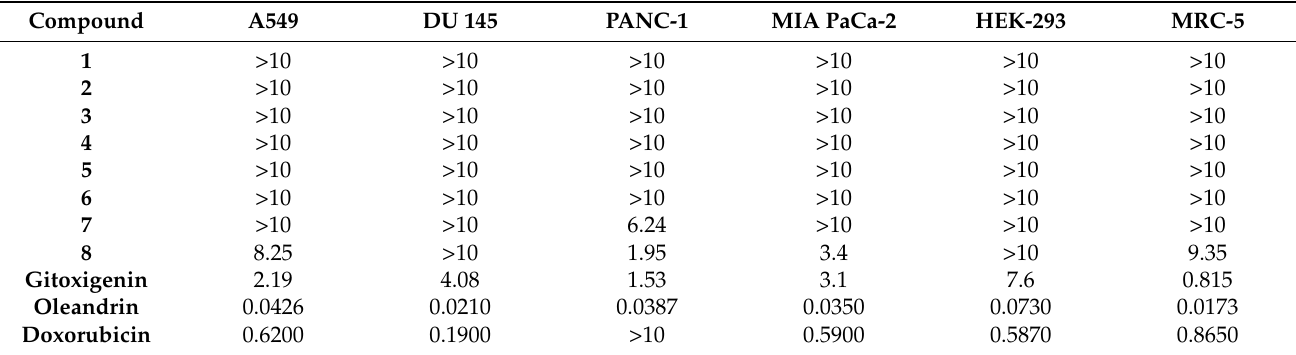
Table 3. Cytotoxic activities of compounds 1 – 8 and the substrate